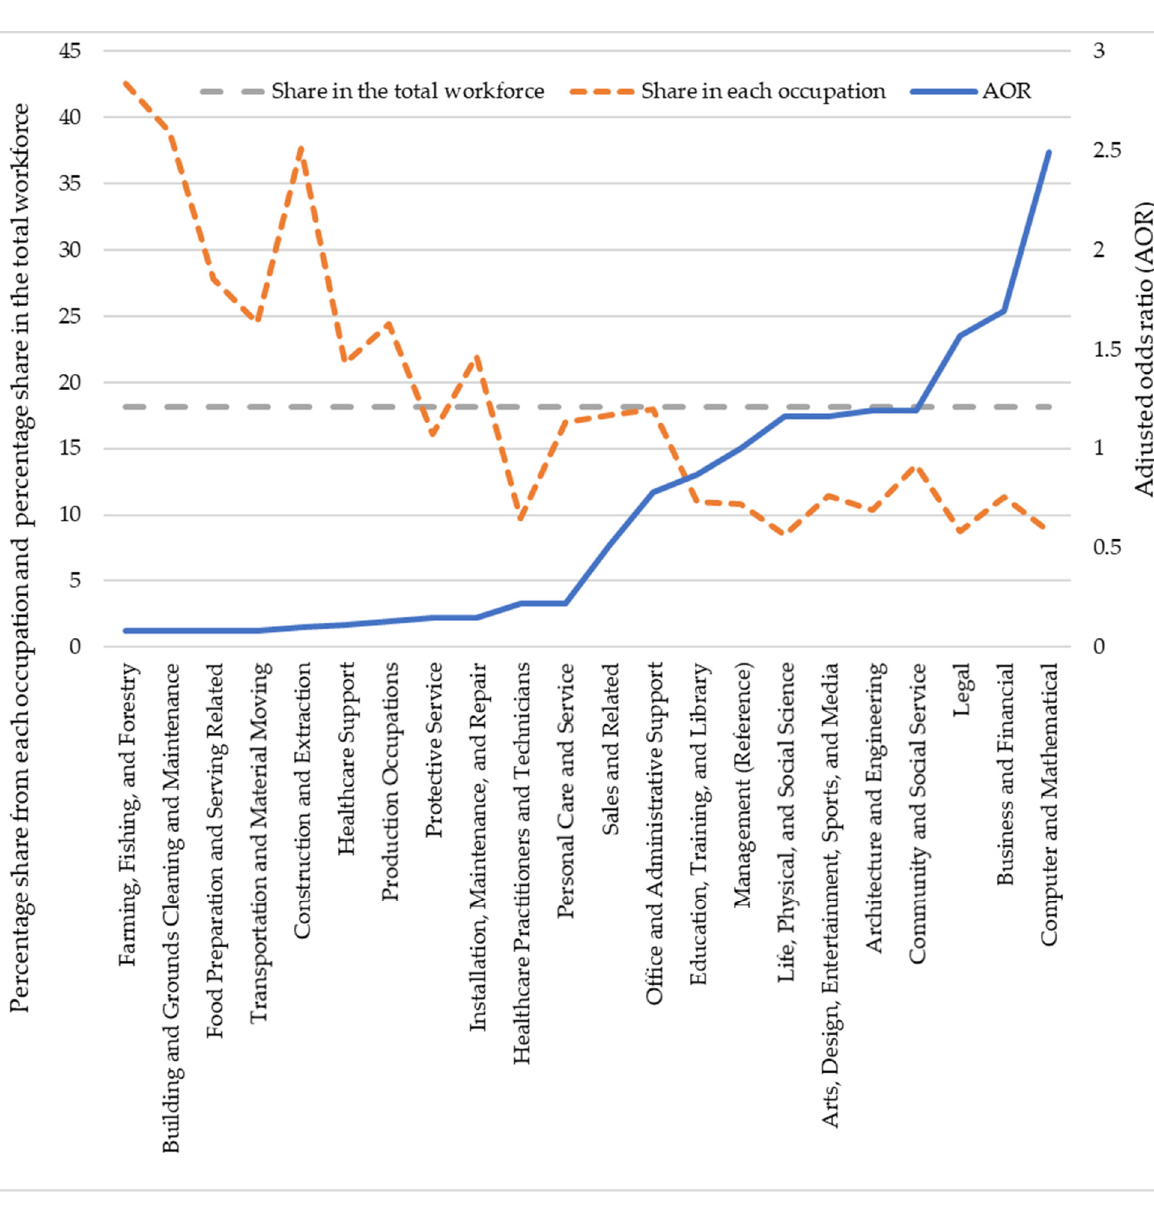
Figure 3. Adjusted odds ratio ( AOR) of teleworking in each occupation and share of Hispanic workers in each occupation and in the total workforce.